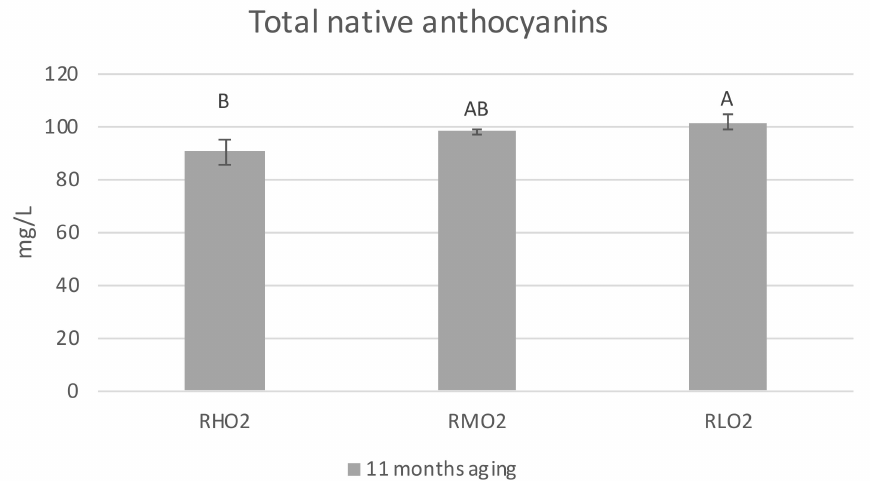
Figure 1. Total native anthocyanin. RHO 2 (red high oxygen), RMO 2 (red medium oxygen), RLO 2 (red low oxygen). All the data are expressed as means ± standard deviation. Different letters indicate a statistically significant difference among treated wines. All the data are expressed as means ± standard deviation, ( p <